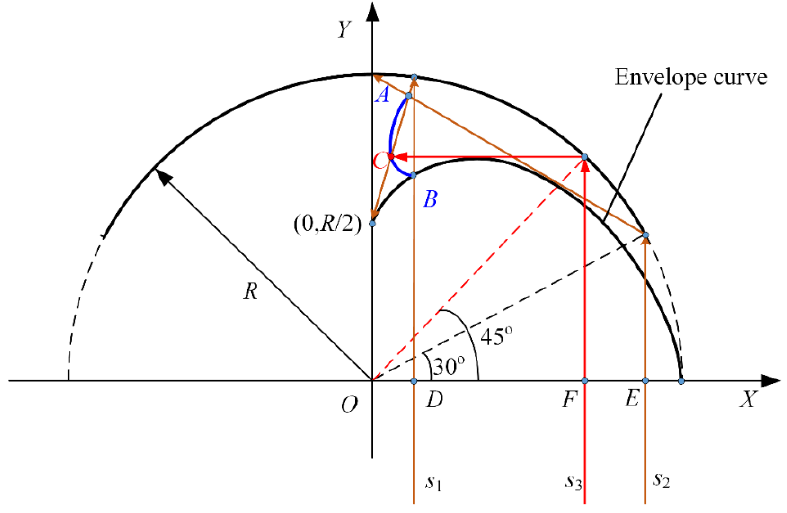
Figure 6. Illustration of the generatrix of the photoelectric conversion system. Suppose an incident ray s 1 intersecting the X -axis at point D intersects the envelope curve at point B , then all incident sunlight from the OD region will be blocked, so the abscissa value of point B determines the self-blocking by the photoelectric conversion system. Another incident light s 2 at the edge of the concentrator with an incident angle of π /3 will intersect the Y -axis at point (0, R ), and its reflection intersects the reflection of s 1 at A point. As known from the concentrating characteristic of the concentrator, all incident sunlight from the DE region will be concentrated on the curve AB